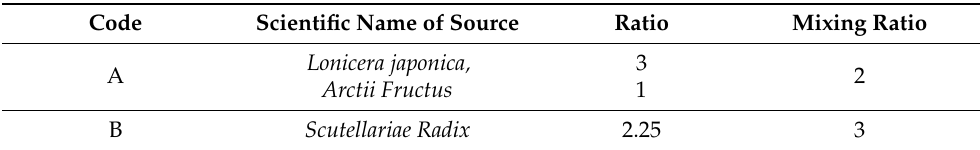
Table 1. Mixing ratio of YG-1